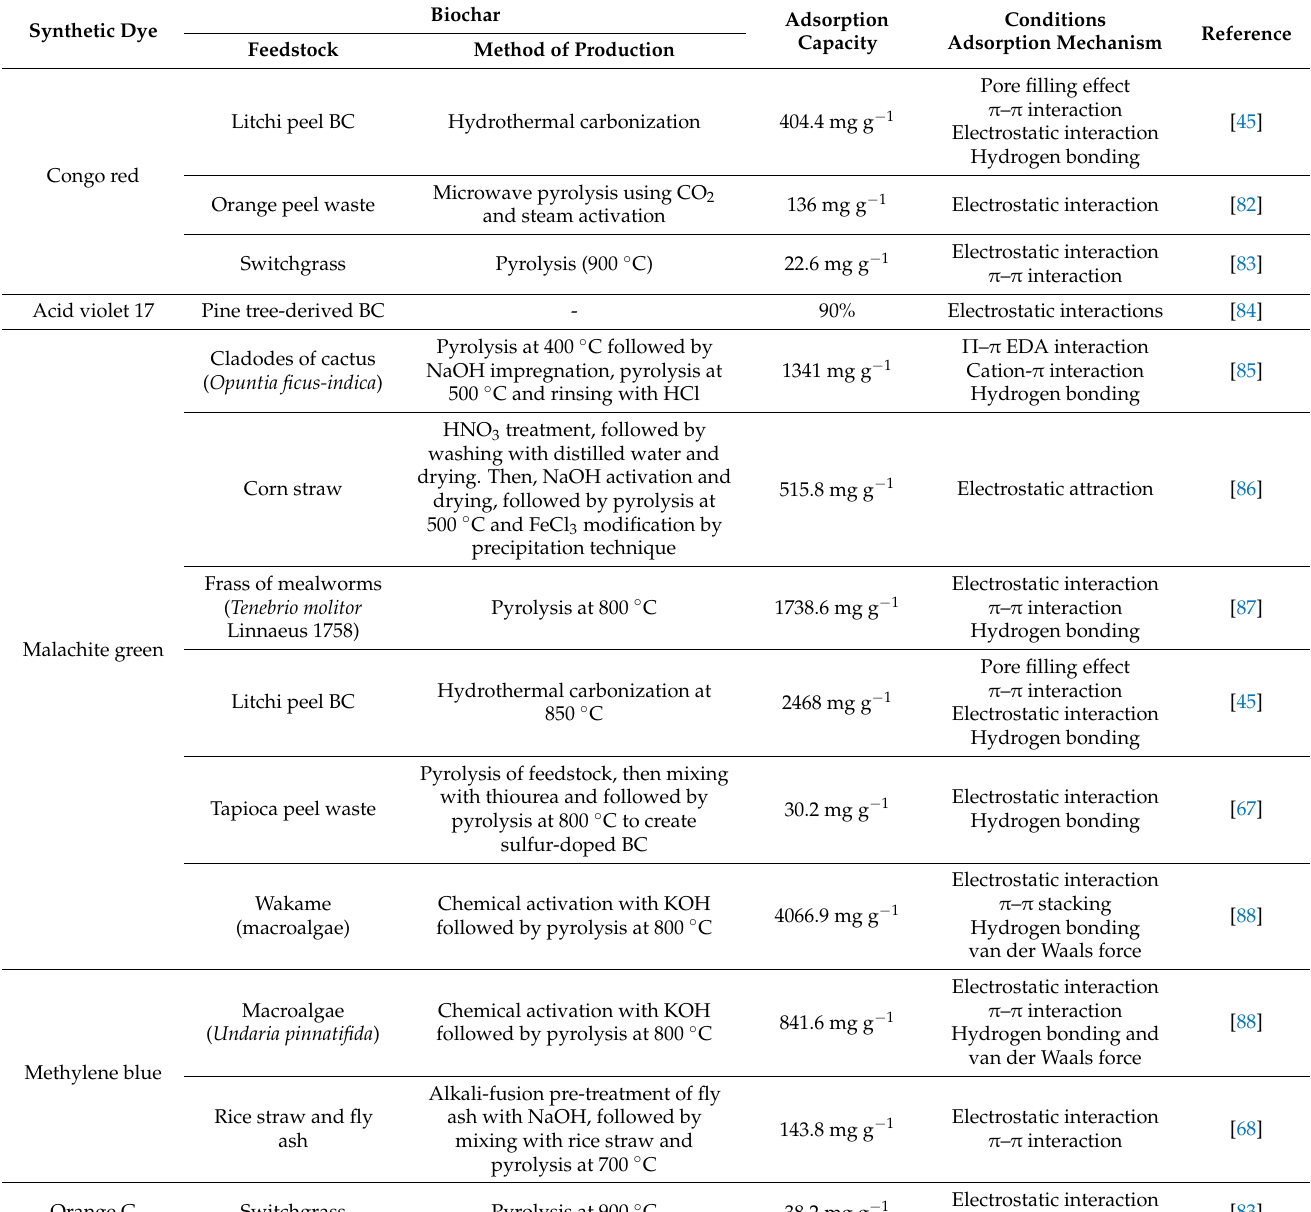
Table 1. Literature summary on modified biochar for dye